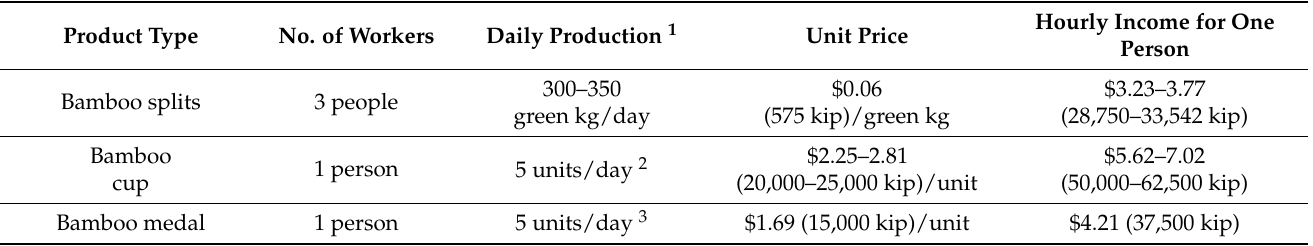
Table 6. Comparison of Nongboua villager’s incomes from the existing and new bamboo product models by labor hour. Product Type No. of Workers Daily Production 1 Unit Price